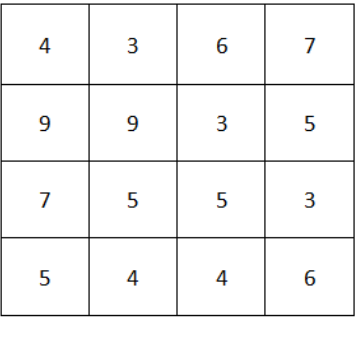
Figure 1. Example of a 4 × 4 grid of numbers the subjects would see.